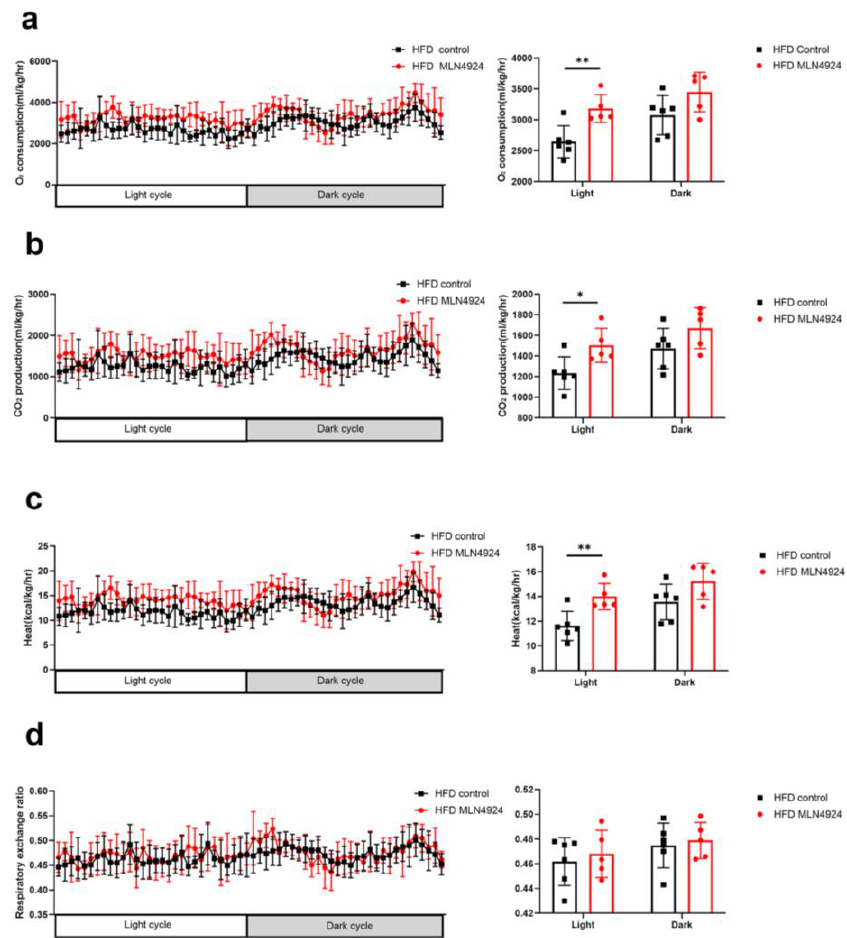
Figure 5. The metabolic conditions of mice can be influenced by MLN4924. ( a – d ) Mice fed with HFD were injected with or without MLN4924. Oxygen consumption, carbon dioxide generation, heat production and respiratory exchange ratio of two groups were measured ( n = 5 – 6 per group). Data represents the mean ± SD, n ≥ 3. A two - tailed Student’s t test was used for statistical analysis (* p < 0.05, ** p < 0.01).